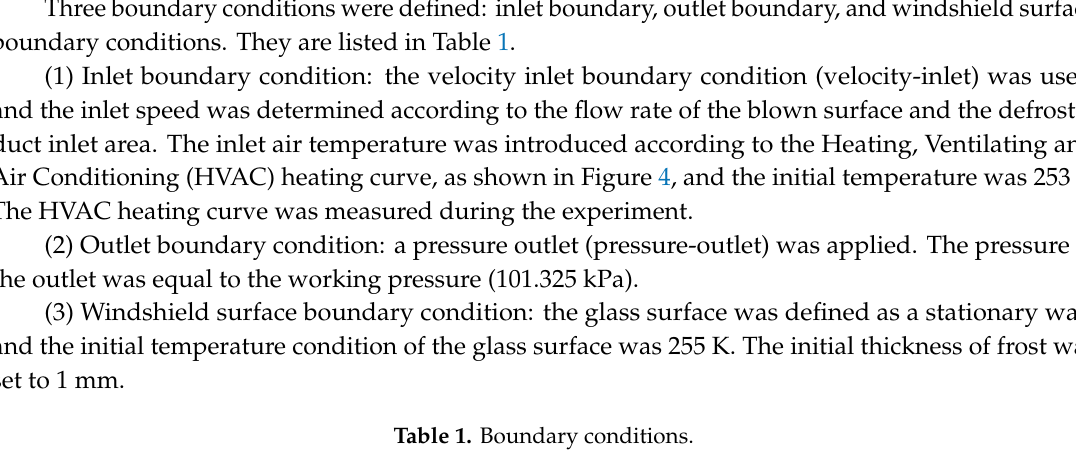
Figure 4. HVAC heating curve of air temperature. Table 1. Boundary conditions.